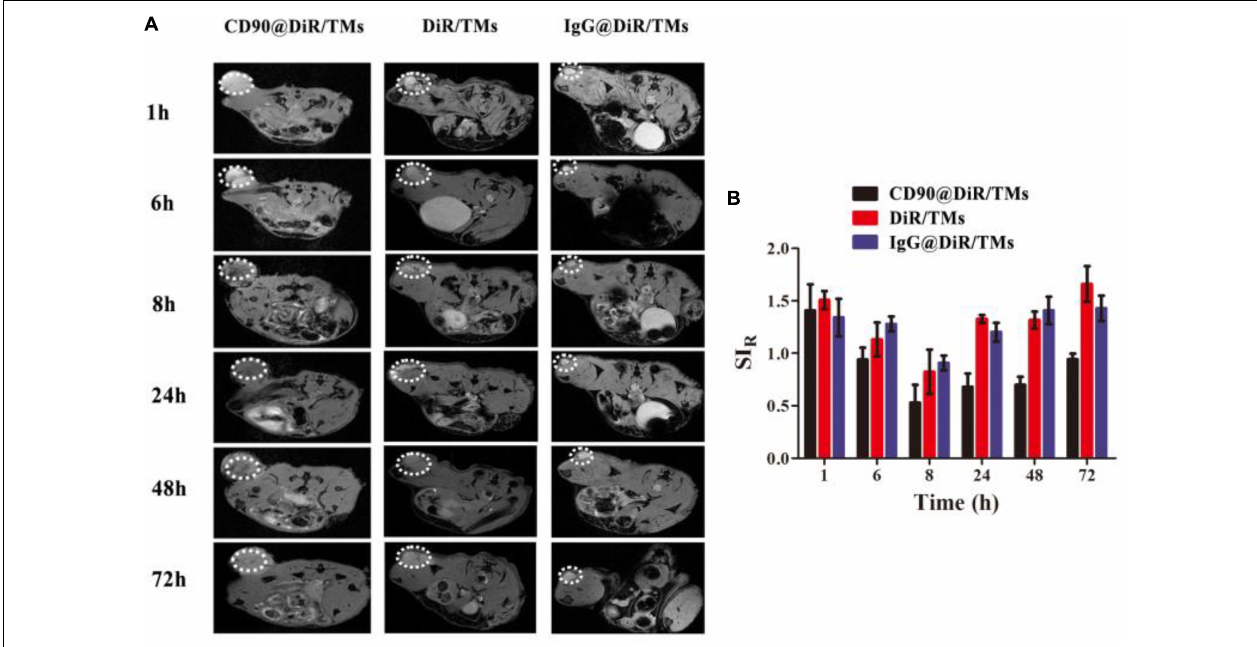
FIGURE 2 | Targeting ability of CD90@DiR/TM in CD90 + LCSC-bearing mice observed using MRI. (A) MRI images at different time points following the injection of IgG@DiR/TMs, DiR/TMs, and CD90@DiR/TMs. (B) Relative signal intensities at different time points following the injection of IgG@DiR/TMs, DiR/TMs, and